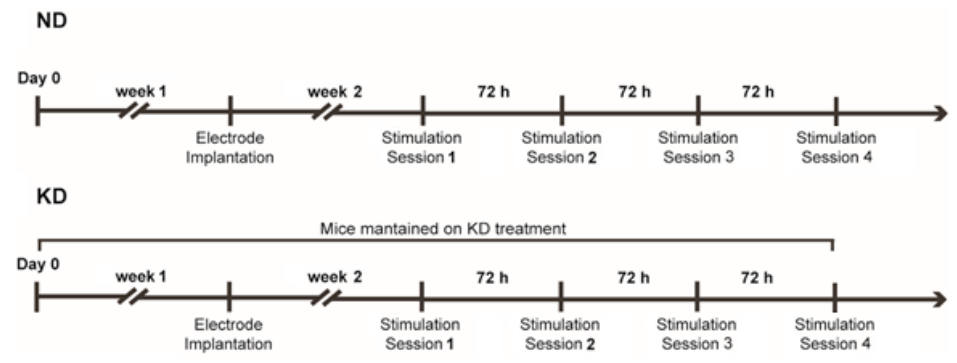
Figure 7. Timeline of the experiment with mice maintained on the normal diet (ND) or on the ketogenic diet (KD) and exposed to various sessions of 6-Hz corneal stimulation. For electrode implantation, mice were anesthetized with ketamine + xylazine (150 + 10 µg/g). Guiding holes were drilled and epidural electrodes (stainless steel Ø = 1 mm; PlasticsOne, Roanoke, VA, USA) were implanted in the frontal (bregma 0 mm, 3 mm lateral from midline) and occipital cortices (bregma − 3.5 mm, 3 mm lateral from midline) of the right hemisphere [25–27]. One electrode was implanted below lambda on the midline and used as reference. At the end of the surgery, gel containing 2.5 g lidocaine chloride, 0.5 g neomycin sulfate and 0.025 g fluocinolone acetonide